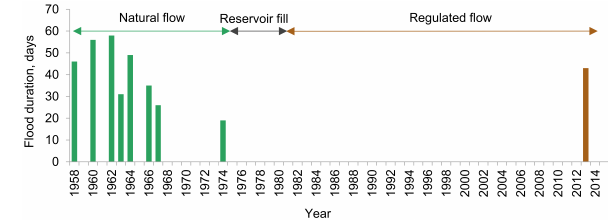
Figure 2. Changes in flood duration at the Belogorye stream gauge located 617km downstream from the Zeya dam.